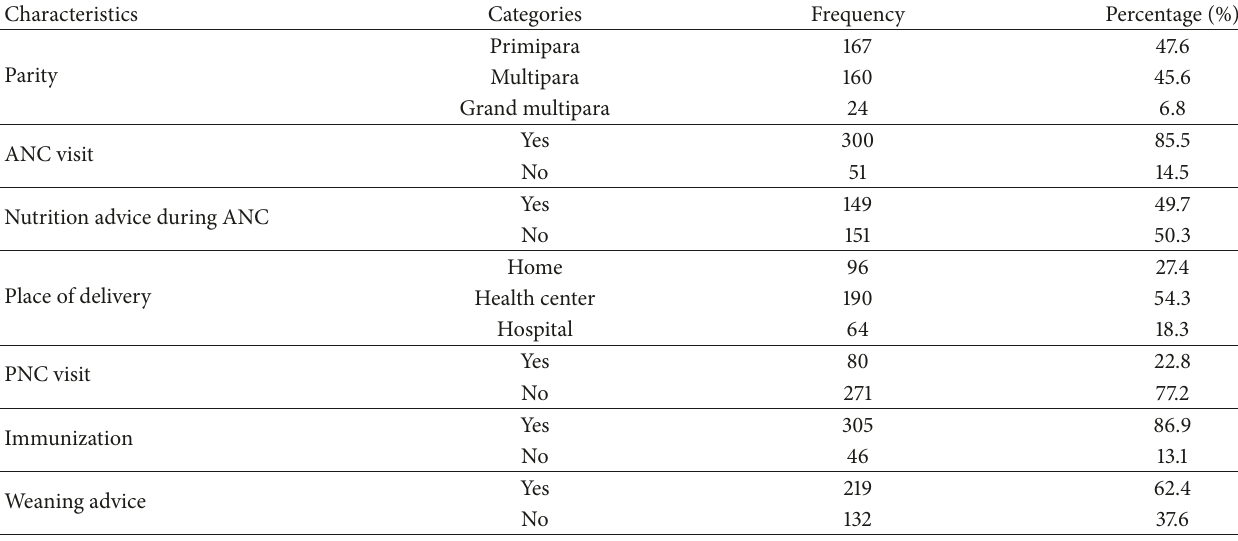
Table 2: Obstetric and child characteristics of participants in Feres Bet, Amhara, Ethiopia, 2016.